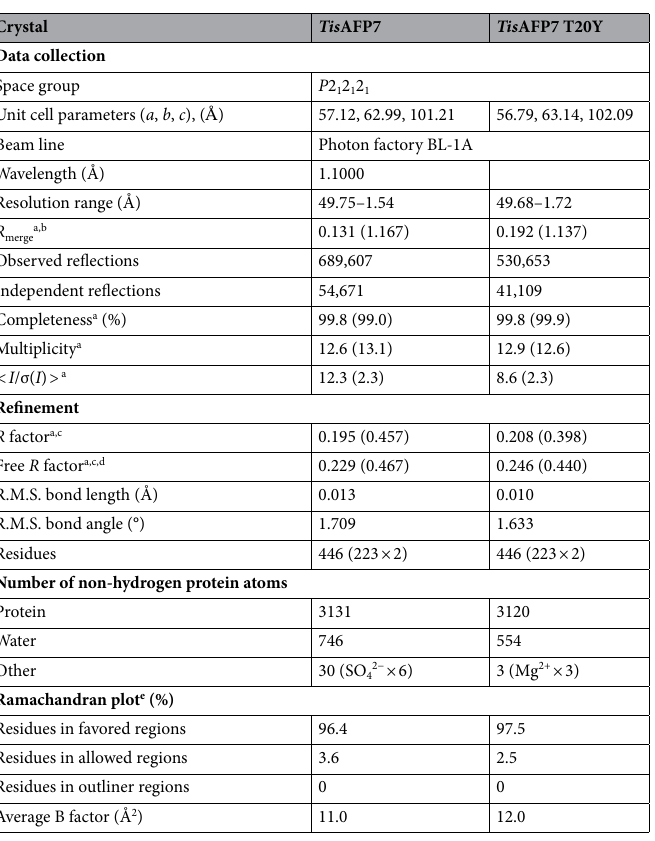
Table 1. Data collection and refinement statistics for Tis AFP7 and Tis AFP7 T20Y. a Values in parentheses are for the highest-resolution shell. b R merge = (cid:31) (cid:31) j (cid:30) (cid:30) � I ( h ) � − I ( h ) j (cid:30) (cid:30) (cid:31) (cid:31) j � I ( h ) � , where (cid:31) I ( h ) (cid:30) is the mean intensity of a set of equivalent reflections. c R factor = (cid:31) || F obs ( h ) | − | F calc ( h ) || (cid:31) | F obs ( h ) | , where F obs and F calc are the observed and calculated structure factors, respectively. d For the calculation, 5% of the data were randomly chosen and the free R factor calculated 58 . e Statistics were obtained from MolProbity 59